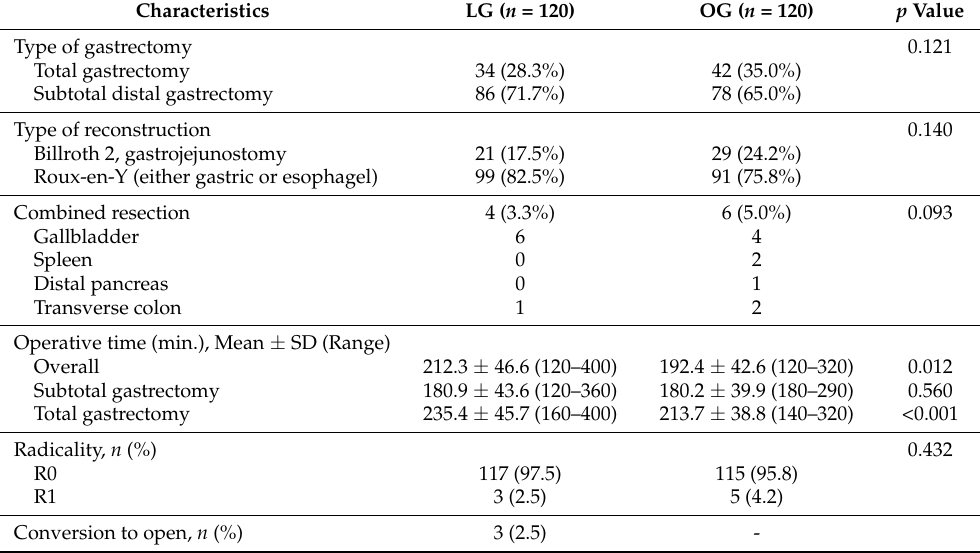
Table 2. Operative findings and pathologic